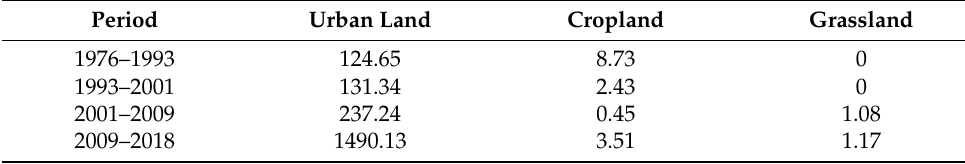
Table 3. The temporal changes in transformed area (ha).